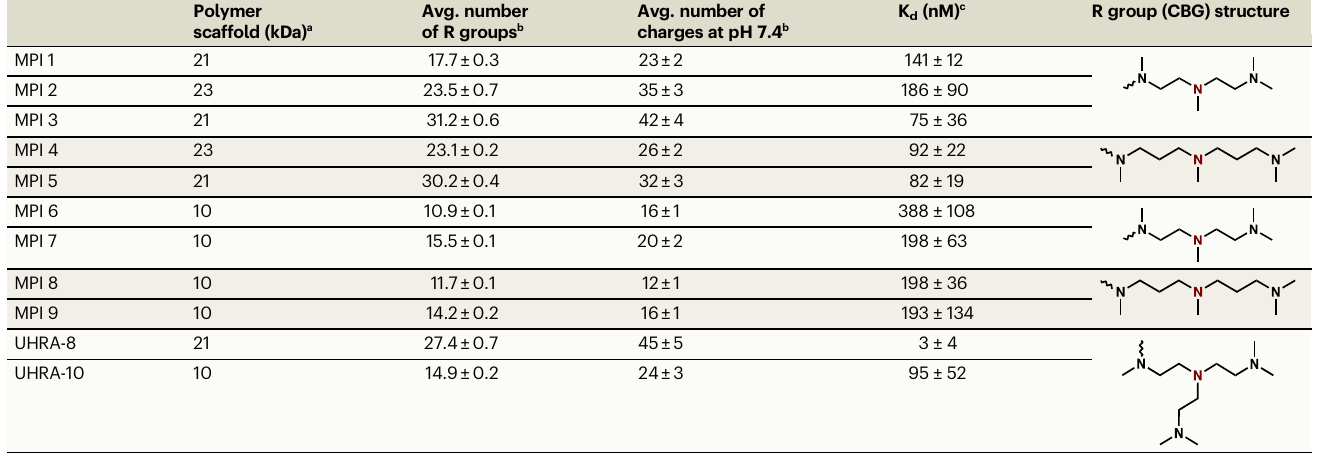
Table 1 | Library of MPIs detailing the structural characteristics at pH 7.4 and 25 °C Polymer scaffold (kDa)